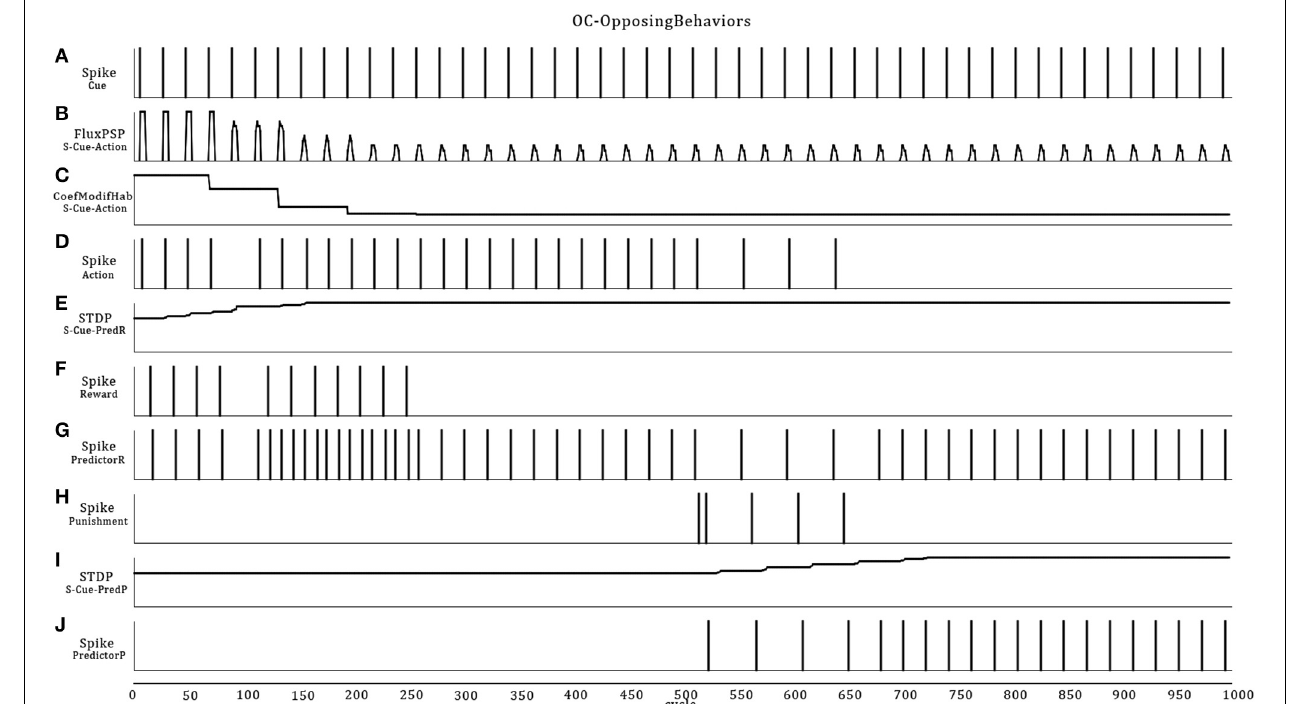
increased amplitude from the STDP rule (E) . When the robot emits a sound, the virtual world responds for the first 250 cycles with a rewarding light (F) . Thus, Cue reaches Action from PredictorP (G) and elicits sounds with the expectation of getting a reward, even if the world ceases to offer it. At cycle 500, the world turns on a punishing heat wave (H) each time the robot emits a sound instead of a rewarding light. The STDP rule (I) at the synapse between Cue and PredictorP increases the synaptic weight until Cue triggers PredictorP (J) alone without punishment.